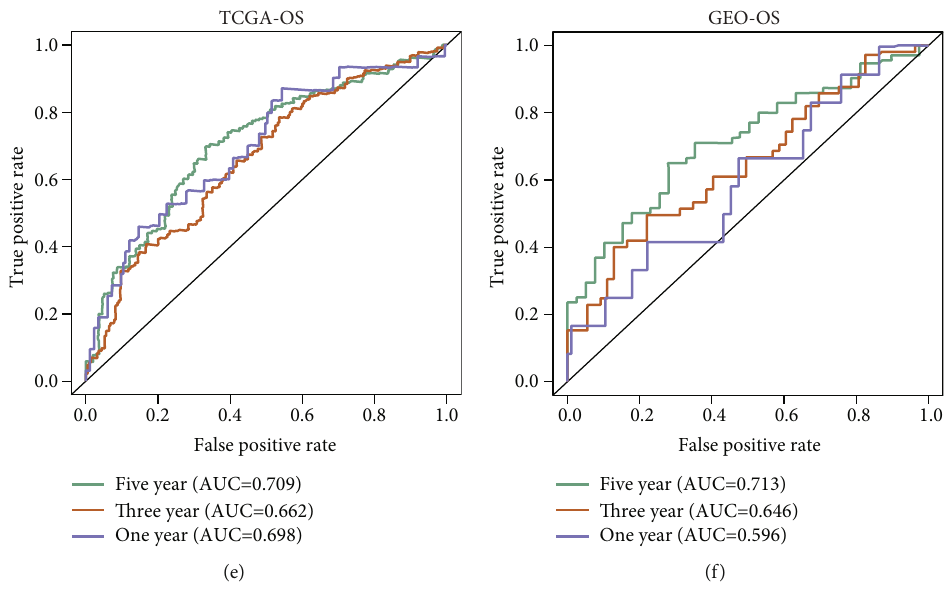
Figure 2: Survival analyses of the MS. (a) Kaplan-Meier survival analysis in TCGA-OS. (b) Kaplan-Meier survival analysis in GEO-OS. (c) Kaplan-Meier survival analysis in TCGA-PFI. (d) Kaplan-Meier survival analysis in TCGA-DSS. (e) ROC analysis of survival prediction at 1, 3, and 5 years in TCGA-OS. (f) ROC analysis of survival prediction at 1, 3, and 5 years in